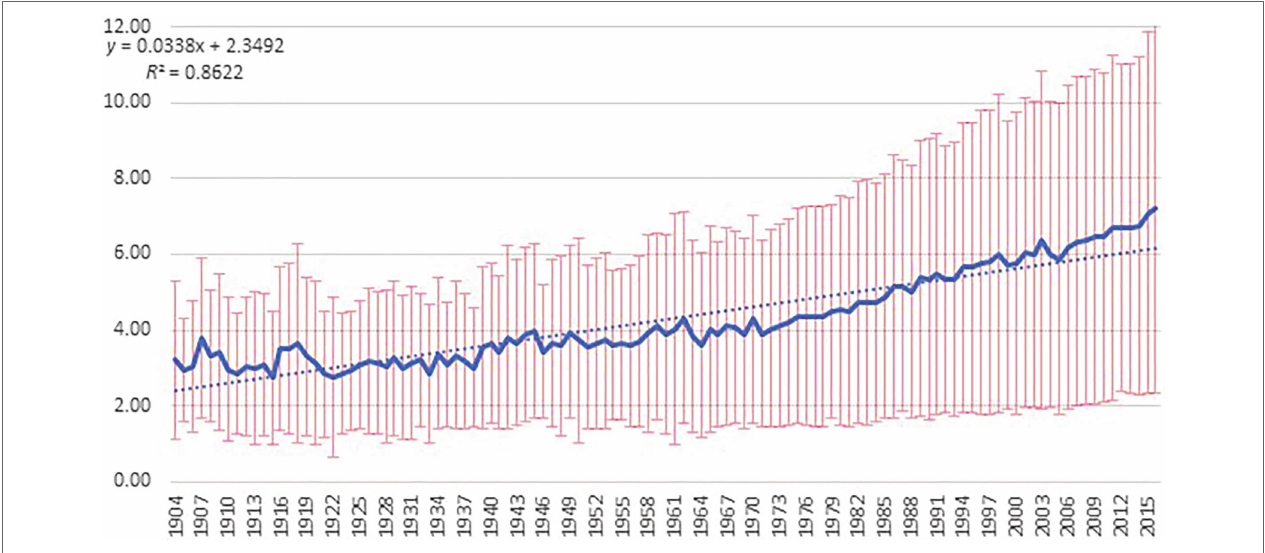
FIGURE 1 | Yearly prevalence of all positive education terms in the complete data